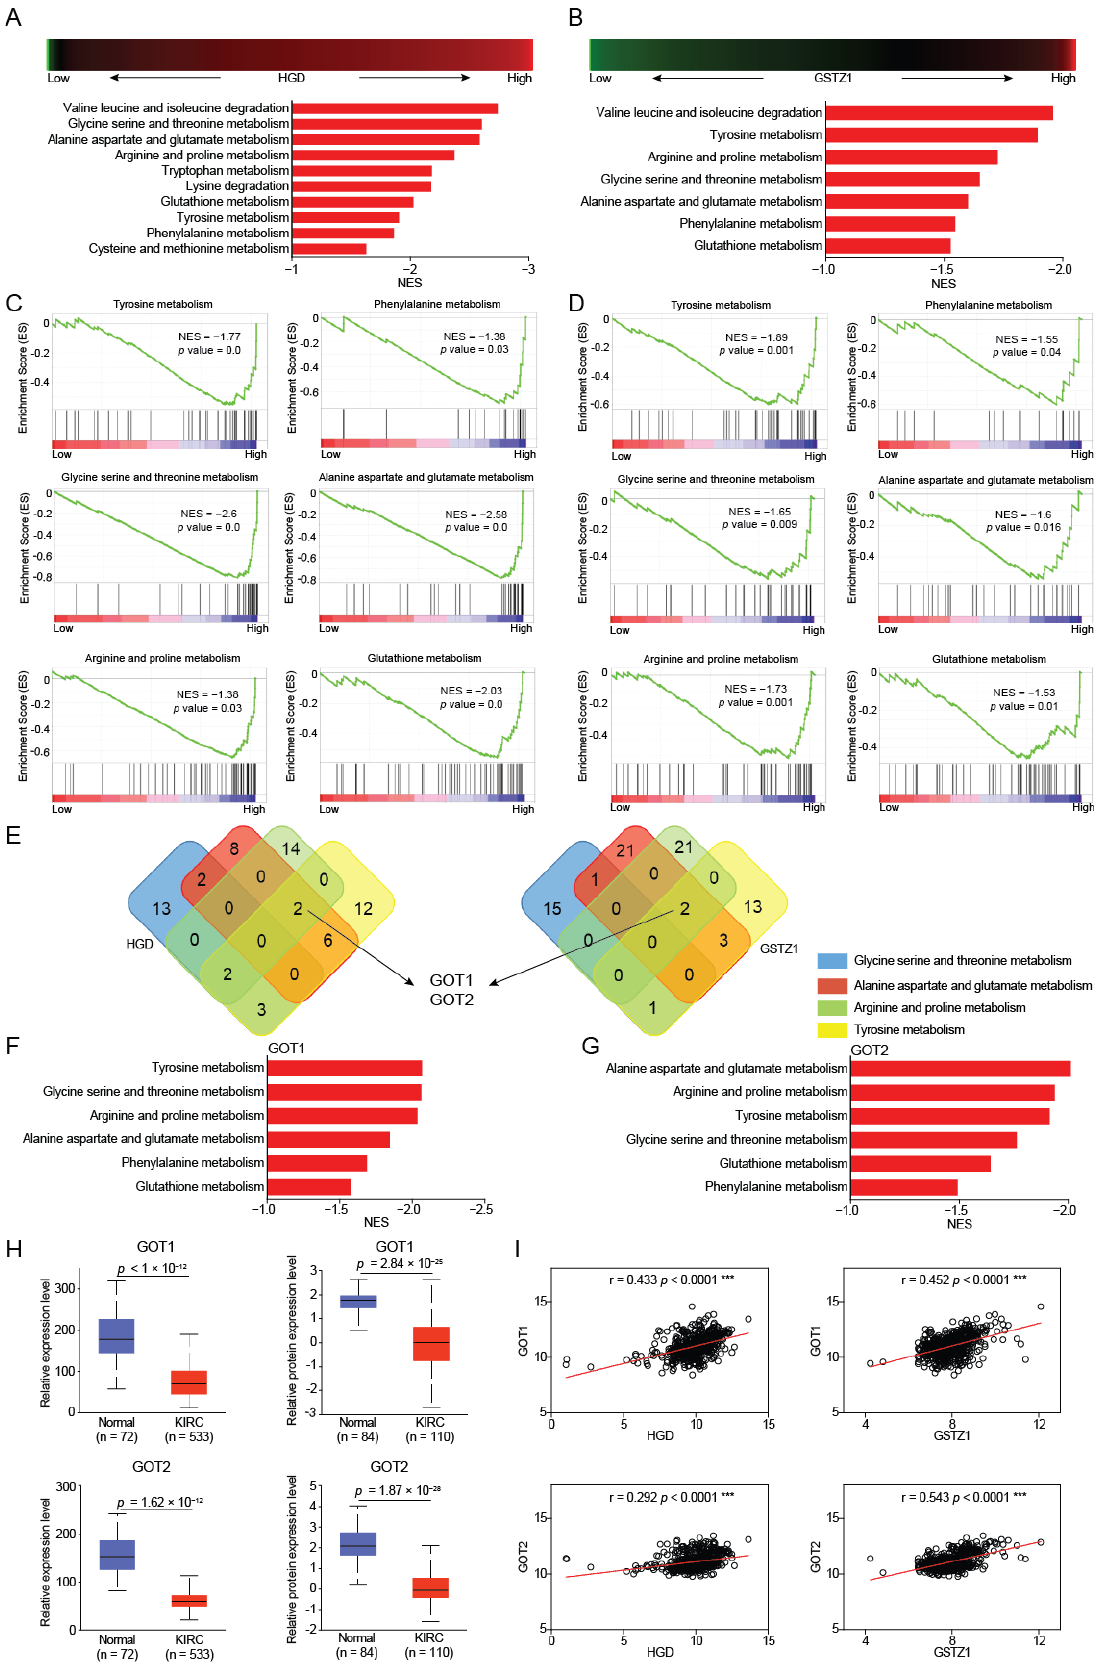
Figure 2. GOT1/2 mediates amino acid metabolism regulated by HGD/GSTZ1. ( A , B ) The